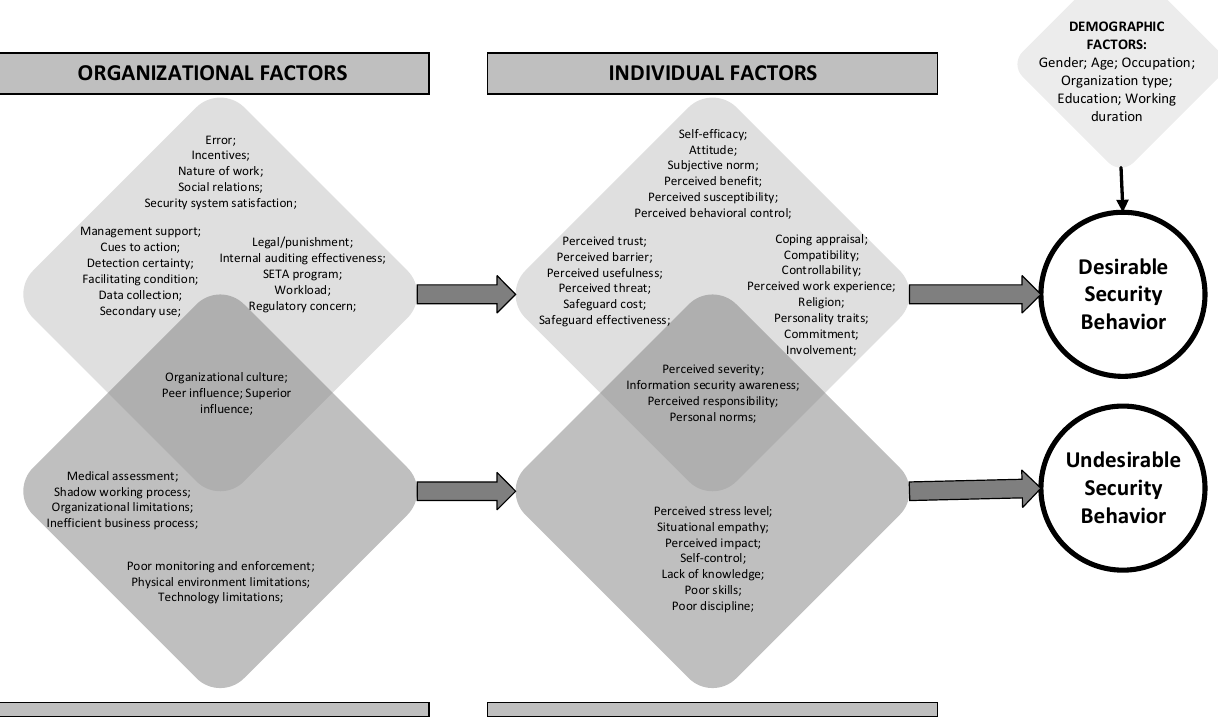
Figure 4. Antecedent factors of information security behavior in healthcare organizations.